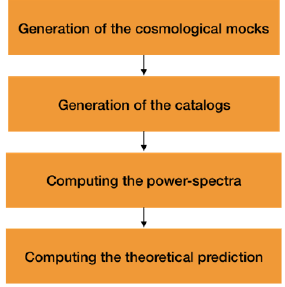
Figure 3: 2-point Statistics Analysis